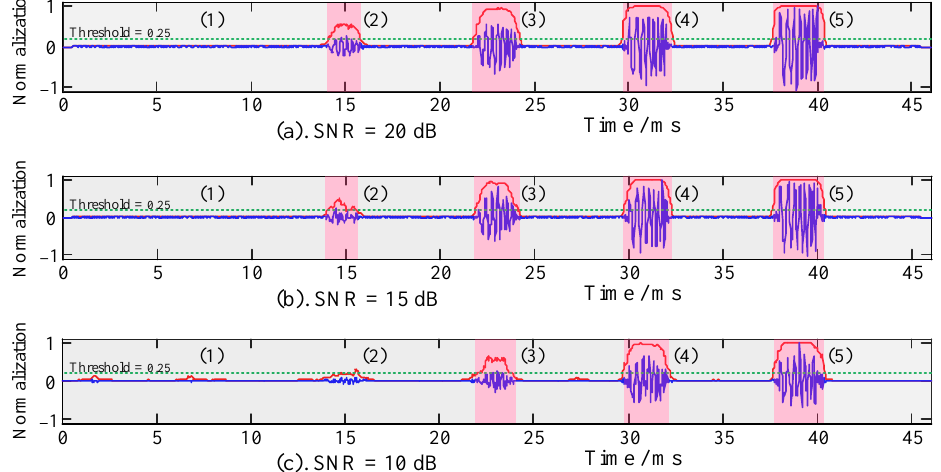
Figure 8. The SRCs of simulated signals with different SNRs. ( 1 – 5 ) The SRCs of the simulated target signals with different energy ratios.